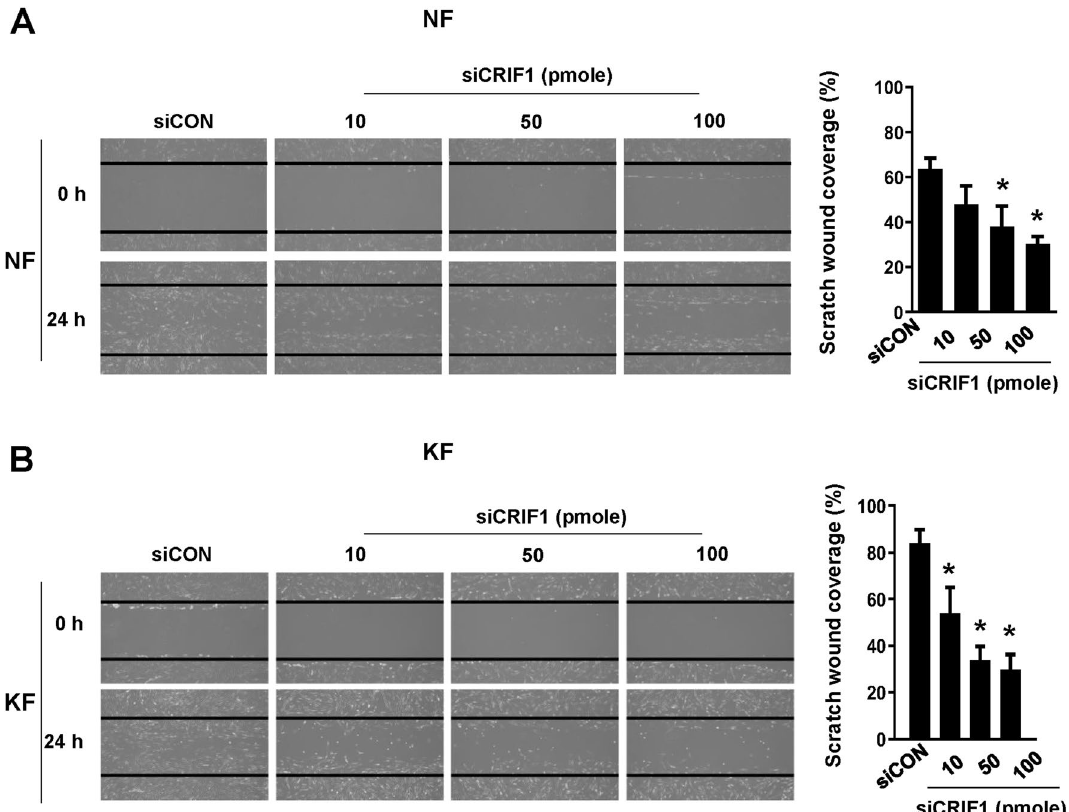
Figure 4. CR6-interacting factor 1 (CRIF1) downregulation leads to decreased cell migration measured by scratch wound healing assay in normal fibroblasts (NFs) and keloid fibroblasts (KFs). ( A ) NFs were transfected with CRIF1 siRNA in a dose-dependent manner for 24 h, followed by wounding for 24 h. ( B ) KFs were transfected with CRIF1 siRNA in a dose-dependent manner for 24 h, followed by wounding for 24 h. Images were taken using a light microscope. Quantification of wound closure was performed using ImageJ software. All data are presented as means ± SD of three independent experiments. * P < 0.05 compared to factors that influence multiple processes including cell migration as well as cell proliferation 20 . Cell migration of NFs and KFs after CRIF1 downregulation was measured using a cell scratch assay. Cells transfected with control or CRIF1 siRNA were incubated for 24 h, after which a scratch was made through the center of each well. Photo- graphs were taken at baseline and 24 h after scratching. NFs (Fig. 4A) and KFs (Fig. 4B) migrated into the wound area and nearly covered the whole scratch after 24 h, while cells transfected with CRIF1 siRNA did not migrate as far suggesting that CRIF1 downregulation significantly reduced cell migration. Cell migration was also measured by the transwell assay. Cells transfected with control or CRIF1 siRNA were incubated for 24 h, after which they were transferred to the upper transwell chamber in serum free medium. The lower chamber contained complete medium. After 24 h of incubation, the migrated cells were stained with DAPI and counted under a microscope. To rule out cell proliferation as the cause of migration in these experi- ments; cells were treated with a cell proliferation inhibitor Mitomycin C. As shown in Fig. 5A,B, mitomycin C treatment slowed down fibroblast proliferation as seen by a reduction in the total cell number (data not shown), but it did not cause complete cell death to affect cell migration and therefore the graph shows that the pattern of cell migration was similar in both the conditions (with or without Mitomycin C treatment). It was confirmed that migration of NFs (Fig. 5A) and KFs (Fig. 5B) was reduced by CRIF1 downregulation. The TGF‑β/Smad signaling pathway is altered by CRIF1 downregulation in normal and keloid fibroblasts. Inhibition of the TGF-β/Smad signaling pathway markedly reduces keloid formation. Protein expression levels of TGF-β, phospho-Smad2, and phospho-Smad3 were measured by Western blotting after transfection of NFs (Fig. 6A,B) and KFs (Fig. 6C,D) with control or CRIF1 siRNA, to examine the changes in the TGF-β/Smad signaling pathway. TGF-β protein expression was significantly reduced in CRIF1-downregulated cells in both NFs and KFs. Similarly, phosphorylation of Smad2 and Smad3 was also decreased in response to CRIF1 downregulation. Subsequently, qPCR was performed to measure changes in the mRNA expression lev- els of the ECM components COL1A1 and COL3A1; the levels of COL1A1 in NFs (Fig. 7A) and KFs (Fig. 7B), and that of COL3A1 in NFs (Fig. 7C) and KFs (Fig. 7D) were all significantly decreased in response to CRIF1 downregulation.